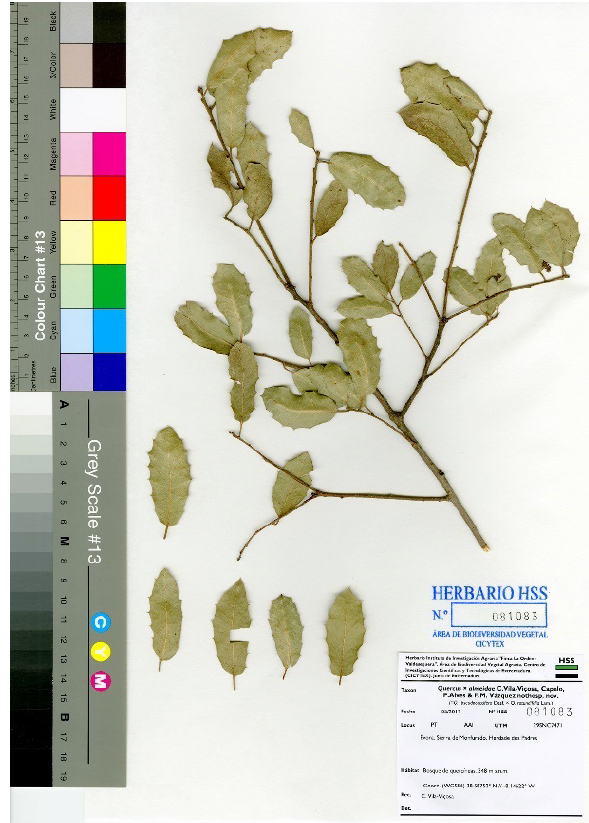
Figure 3 . Holotype of Q. × almeidae Vila-Viçosa, Capelo, P.Alves & F.M. Vázquez nothosp.nov. HSS - 081083! Description: Shrub up to 100 cm among parents. Leaves ovate-obovate to lanceolate, blade with (9)12- 20(24) x (4)6-14(17) mm, entire margin in the first